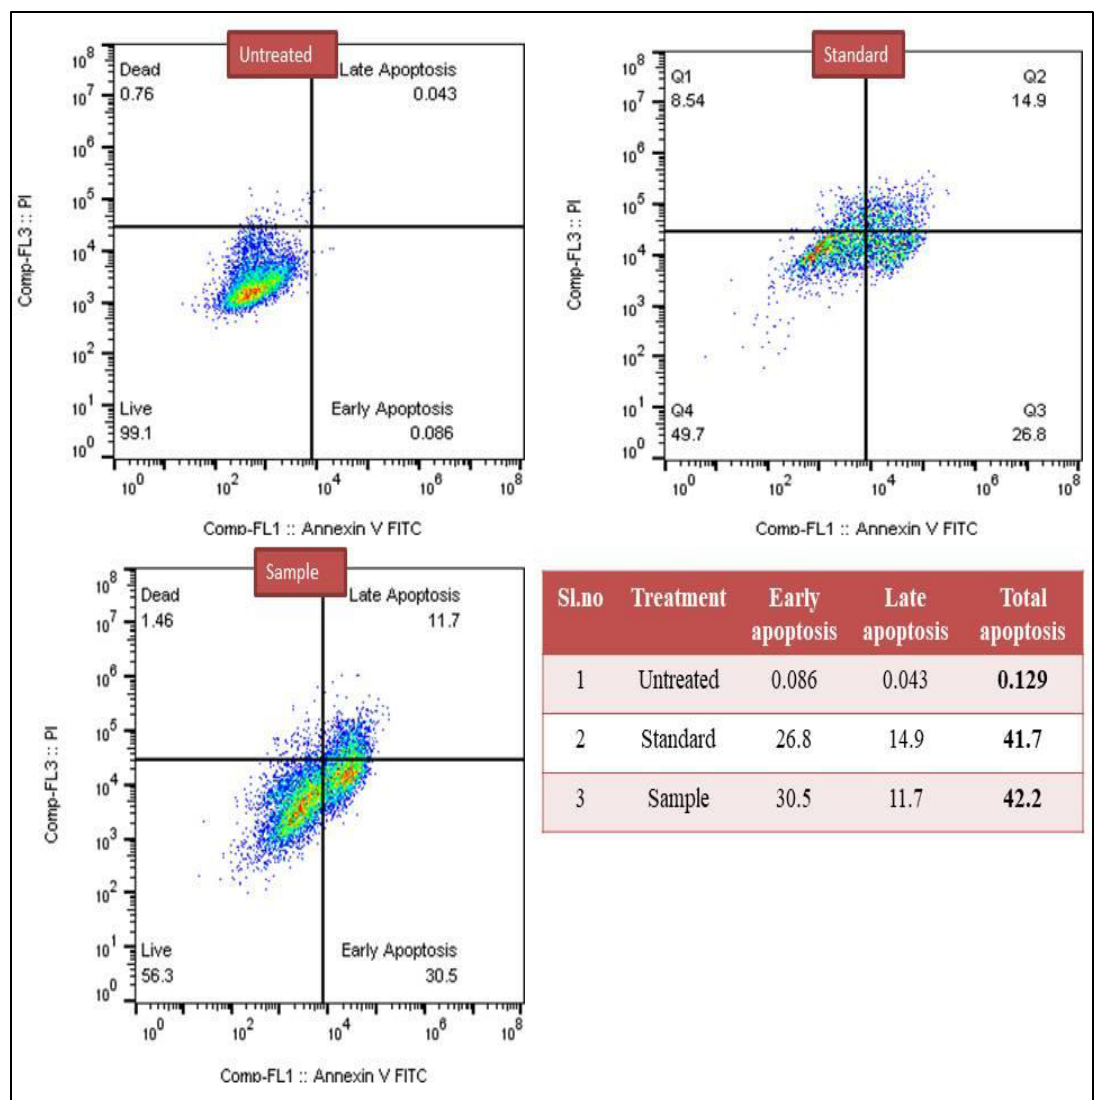
Figure 1. Detection of early and late apoptosis induced by methanol extract of C. colocynthis in the lung cancer A549 cell line.